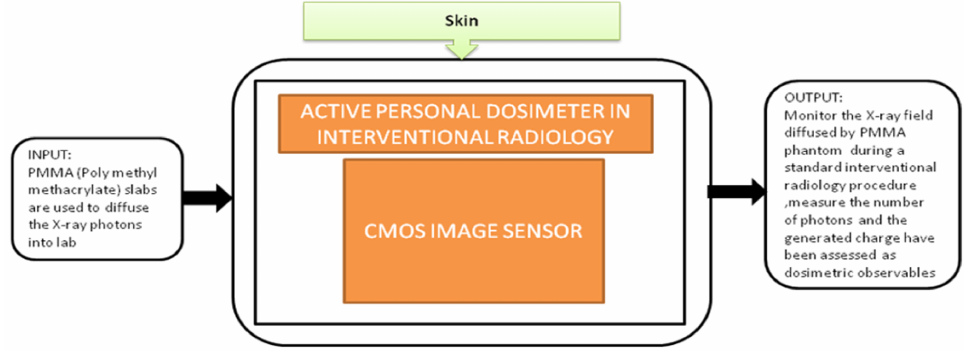
Figure 24. Active personal dosimeter in interventional radiology.